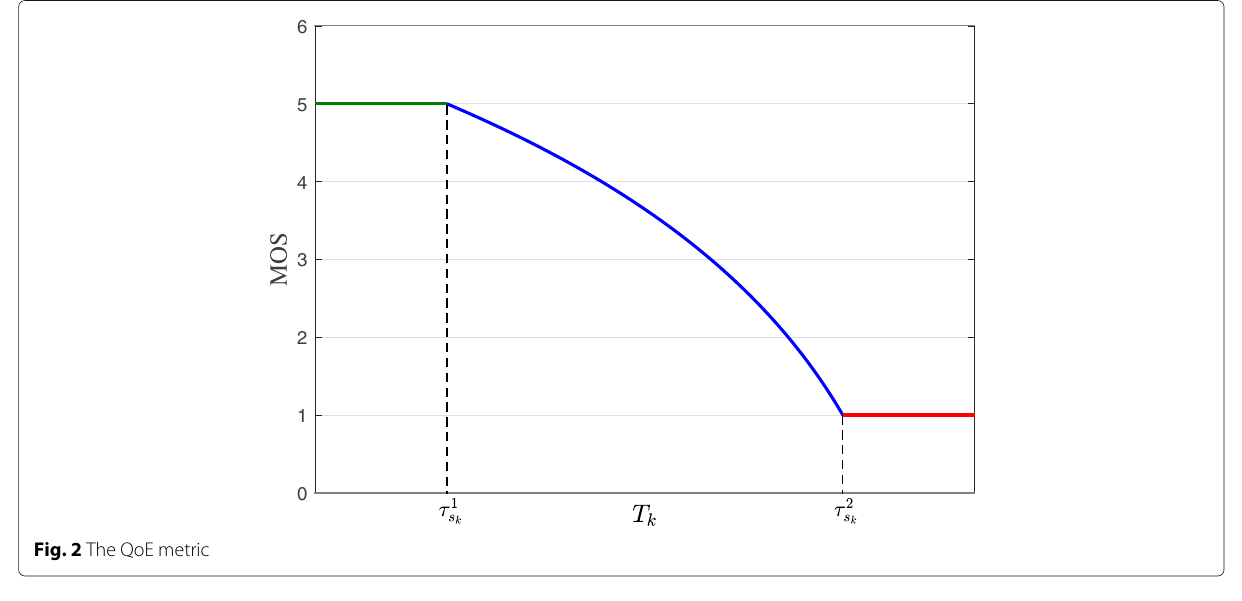
change of delay. The MOS values range from 1 to 5, where MOS = 1 represents an unacceptable QoE for SOs and MOS = 5 reflects an excellent user experience. In general, SOs have different tolerances for delay with regard to the different services. The application characteristics of SOs and τ 2, s are determined by τ 1, s k k